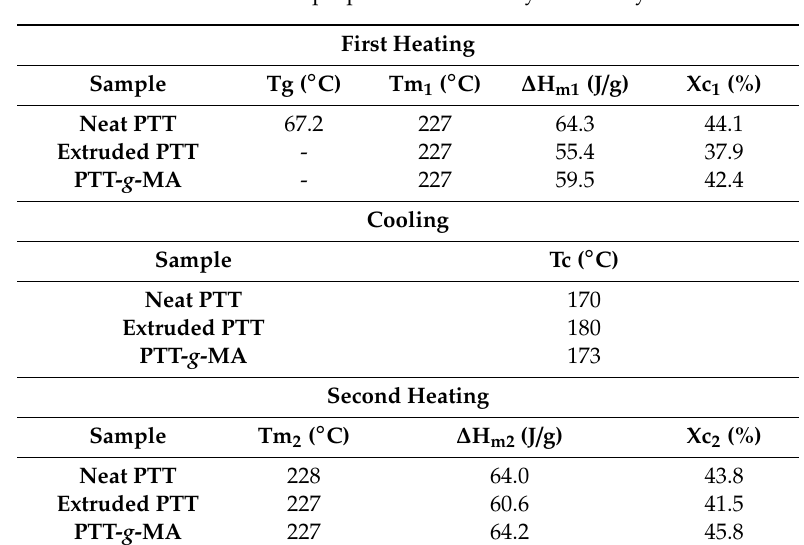
Table 1. Thermal properties obtained by DSC analysis.